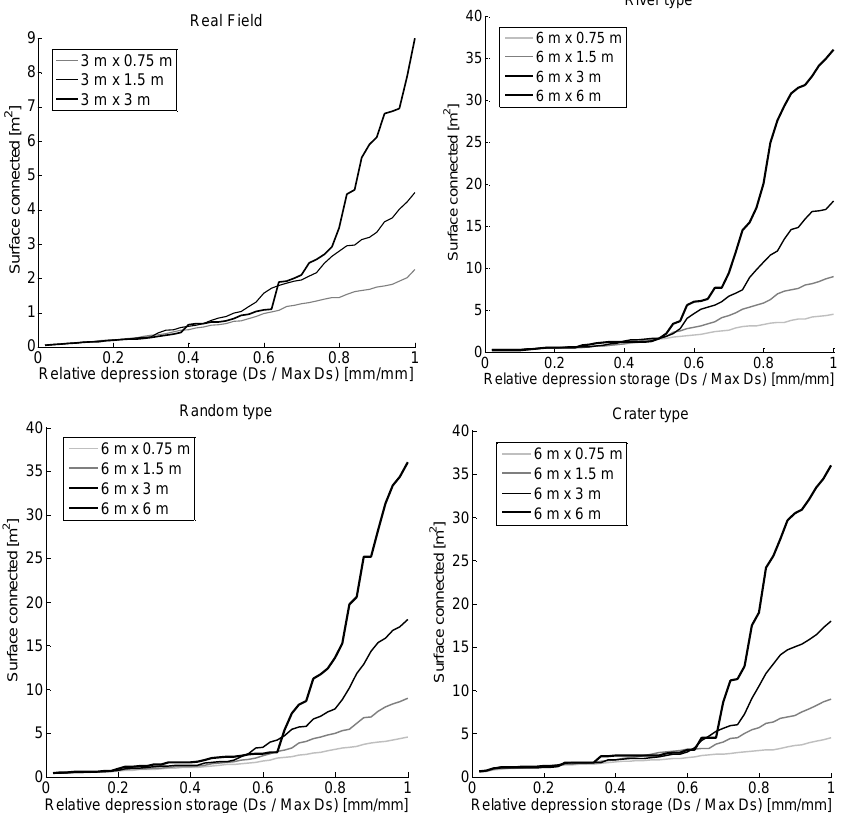
Fig. 17. Surface of the area connected to the outflow boundary, in absolute units (m 2 ), as a function of the relative depression storage for the Figure 17 Surface of the area connected to the outflow boundary, in absolute units (m²), as a 3 four microtopography function of the relative depression storage, for the four microtopography types. 4